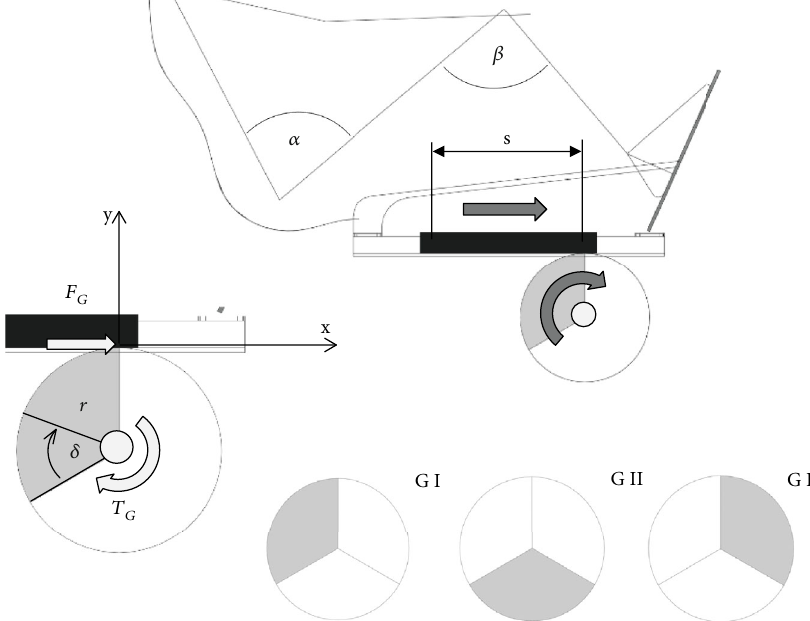
Figure 7: The gantry — model for